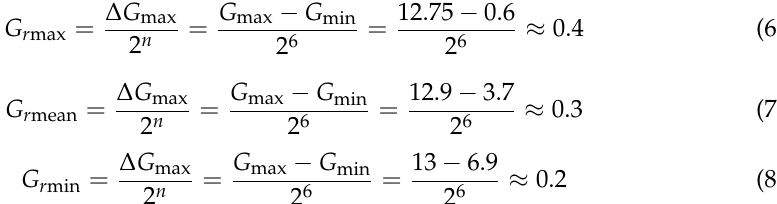
Figure 10. Measured gains versus gain mode under different control modes at 25.4 GHz. The RMS phase error was used to characterize the phase variation in the VGA. The specific formula for calculating RMS phase error is expressed as